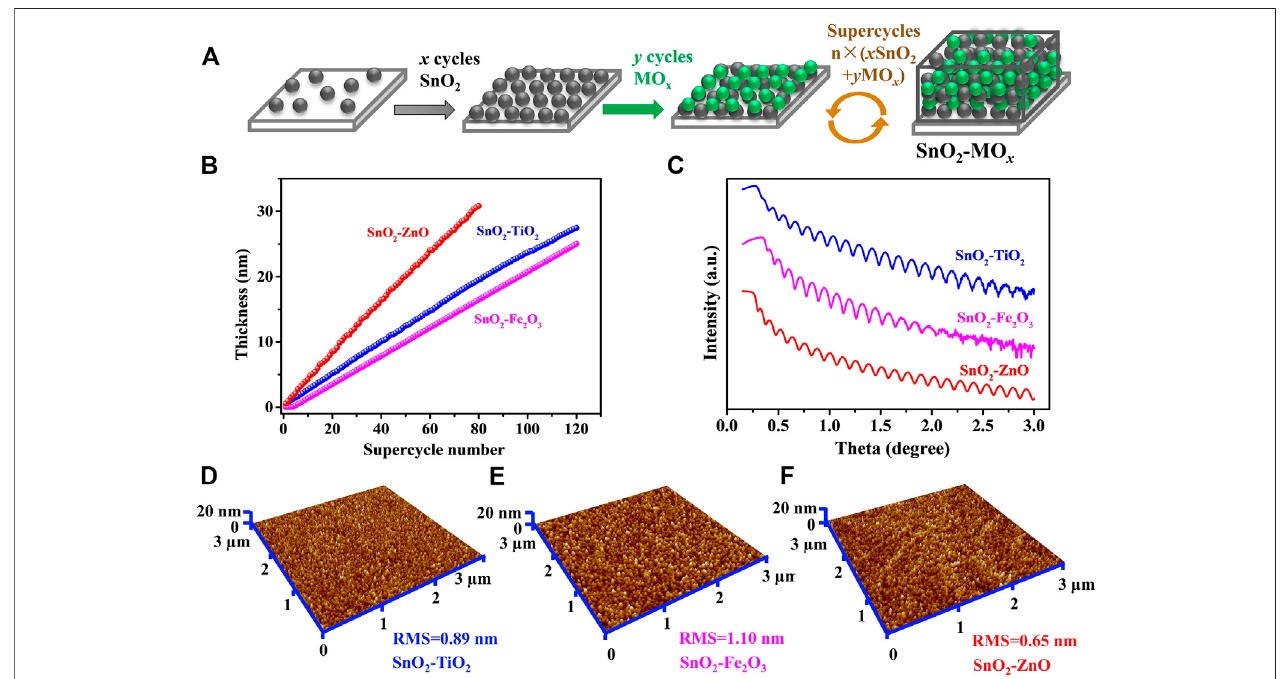
FIGURE 1 | ALD of SnO 2 – MO x composite thin- fi lms. (A) Scheme of the supercycles approach n × ( x SnO 2 + y MO x ). (B) Thickness as a function of supercycle numberfrom in-situ SEand (C) XRRcurves.Three-dimensional viewAFMimages oftheALD (D) SnO 2 – TiO 2 , (E) SnO 2 – Fe 2 O 3 and (F) SnO 2 – ZnOthin- fi lms.Thescaleis 3 × 3